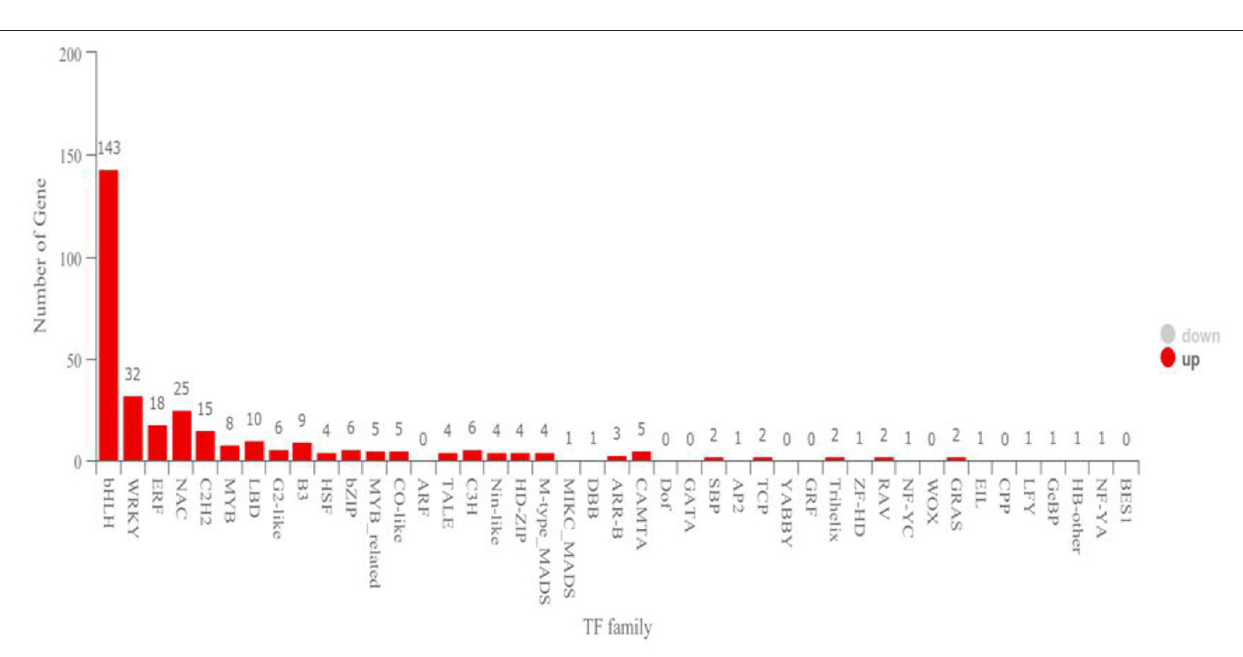
Frontiers in Microbiology |